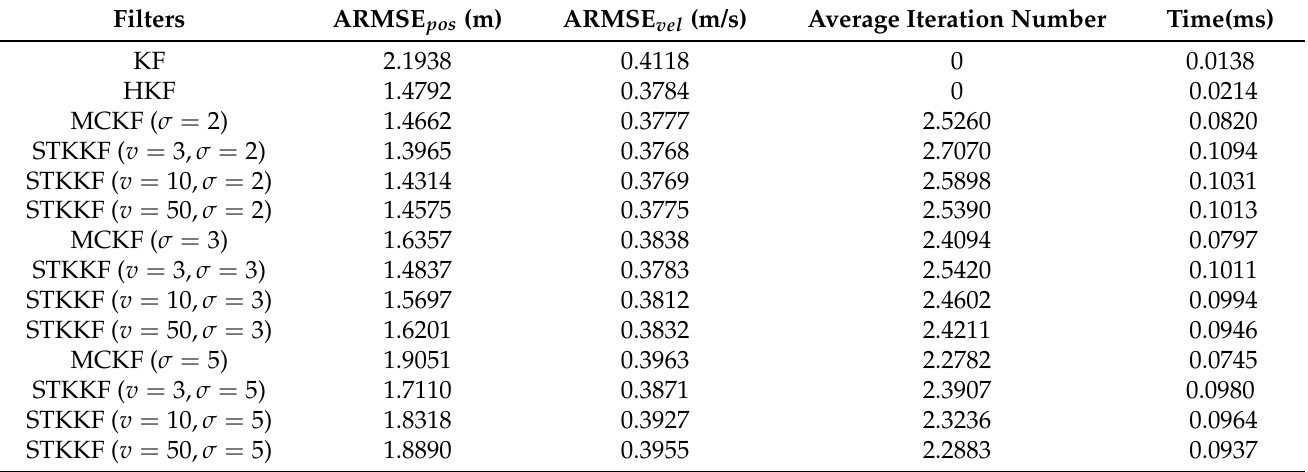
Table 2. ARMSEs of position and velocity, average iteration numbers, and average implementation times for one time step of different algorithms when the measurement noise is mixed Gaussian